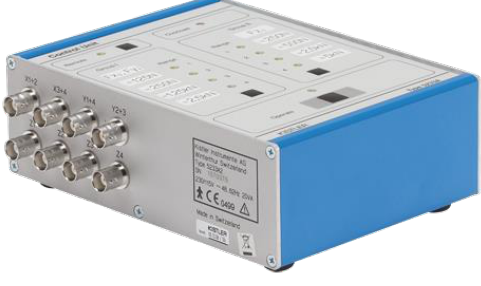
Figure 5. External control